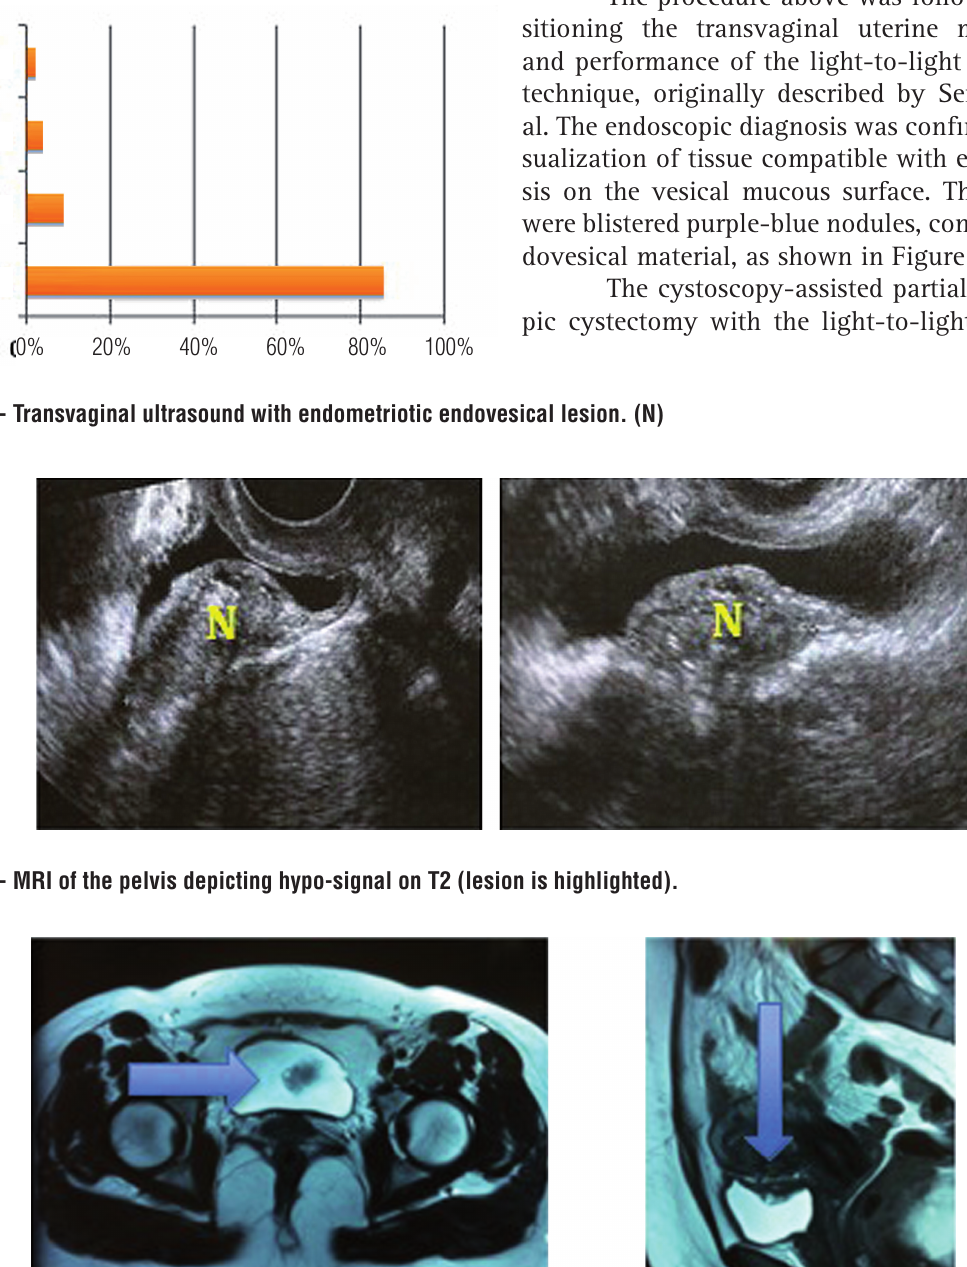
Figure 1A - Endometriosis incidence in utrinary tract